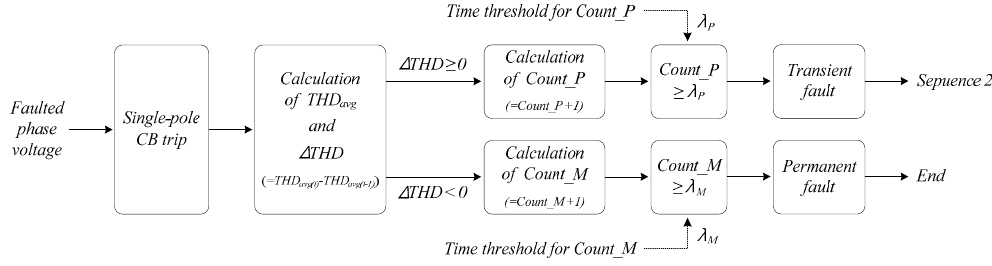
Figure 10. Diagram of the proposed scheme for discrimination of the fault